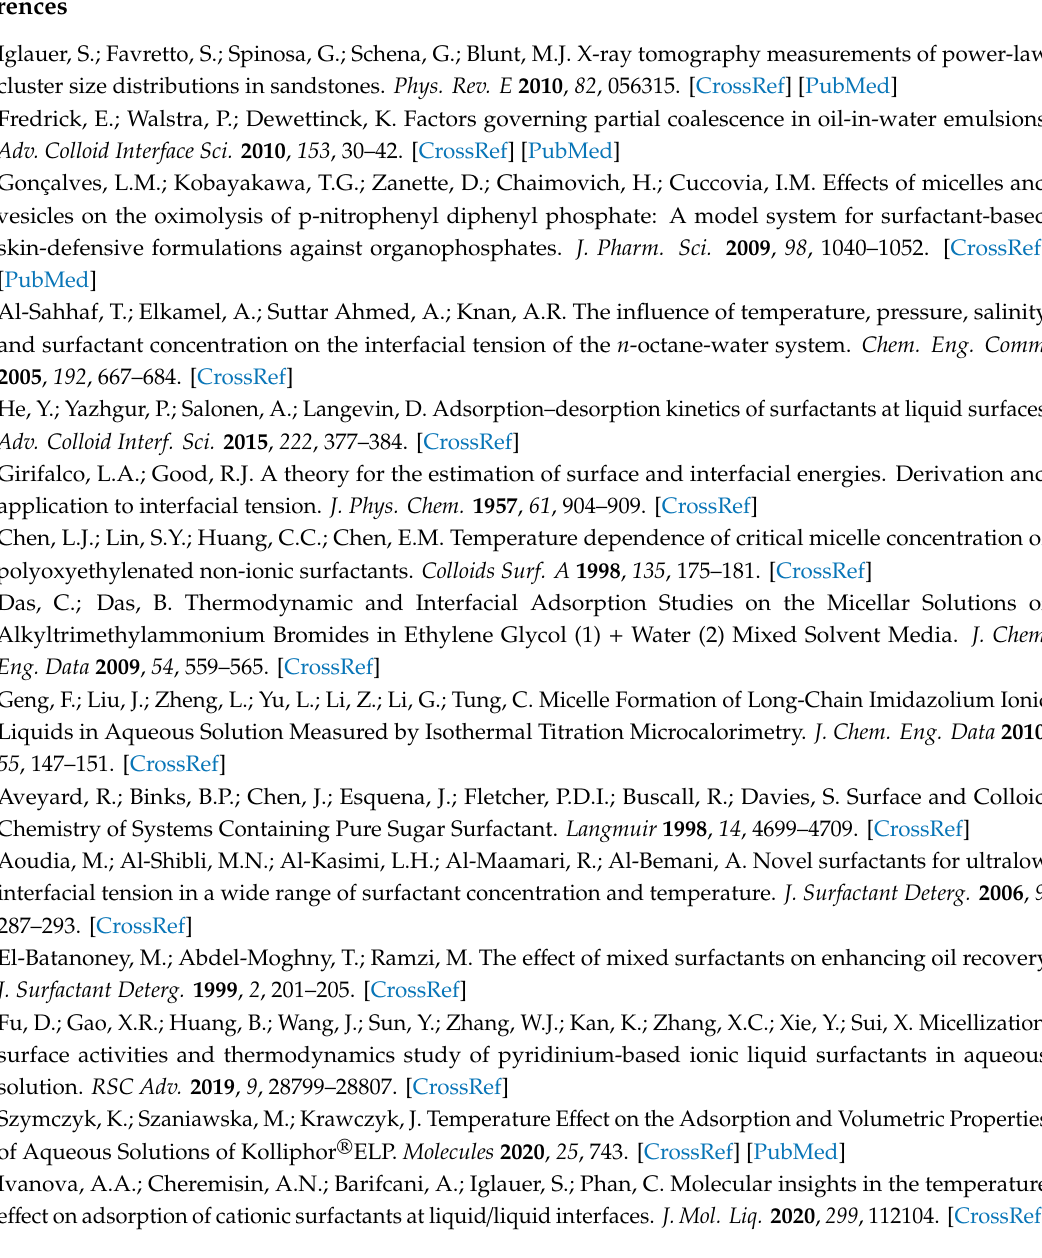
Same as Figure S3. Graph rotation: Horizontal view = 120 ◦ ; Vertical view = 15 ◦ . Figure S5: Same as Figure S3. Graph rotation: Horizontal view = 240 ◦ ; Vertical view = 15 ◦